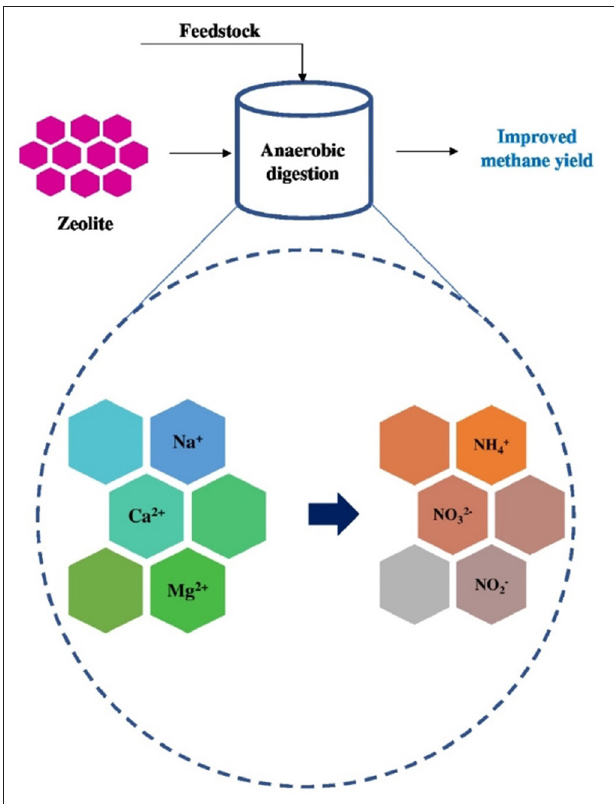
FIGURE 5 | Cation exchange property of zeolite with inhibitors in anaerobic